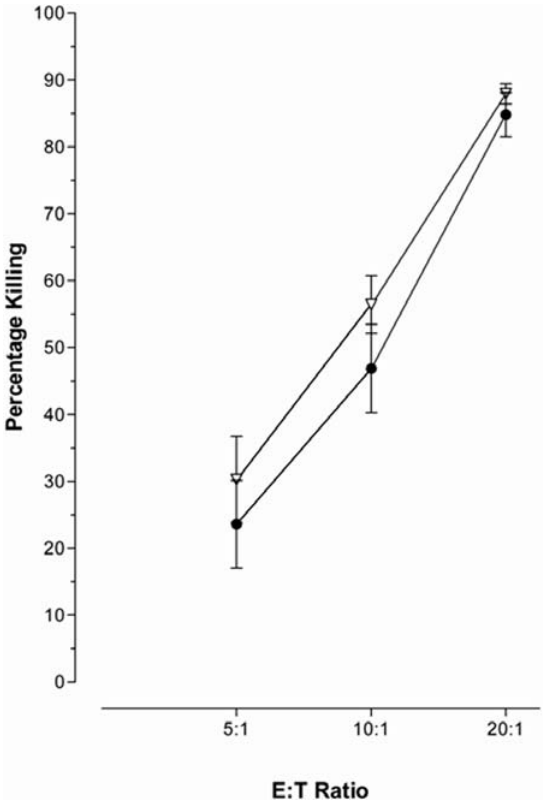
Figure 2. IFN- treatment did not protect a B-cell line. Treatment of a BCL with 1000 IU/ml IFN- a (open inverted triangles) prior to the cytotoxicity assay, did not reduce CTLs ability to kill the treated BCL compared to the untreated BCL (closed